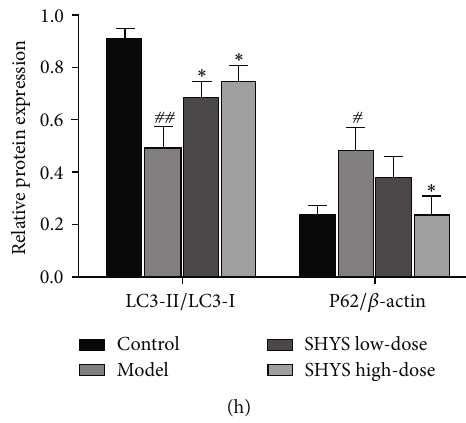
Figure 3: E ff ects of SHYS on PINK1/Parkin-mediated mitophagy in DKD model rats. The changes in morphology of the mitochondria in the kidney in each group were observed by transmission electron microscopy and the levels of proteins related to PINK1/Parkin-mediated mitophagy were detected by western blot. (a, b) Transmission electron microscopy showed that SHYS treatment improved the morphology of mitochondria in kidney (M indicated mitochondria and MS indicated mitophagosomes) ( 10,000 × ) (a). The percentage of fragmented mitochondria in transmission electron microscopy was calculated. SHYS treatment decreased the percentage of fragmented mitochondria in the kidney (b). (c, d) SHYS treatment decreased the levels of VDAC1, TOM20, and COXIV in kidney. (e, f) SHYS treatment increased the levels of PINK1 and Parkin in the kidney. (g, h) SHYS treatment increased the level of LC3-II and decreased the level of p62 in kidney. # : P < 0 : 05 compared with the control group; ## : P < 0 : 01 compared with the control group; ∗ : P < 0 : 05 compared with the model group; ∗∗ : P < 0 : 01 compared with the model